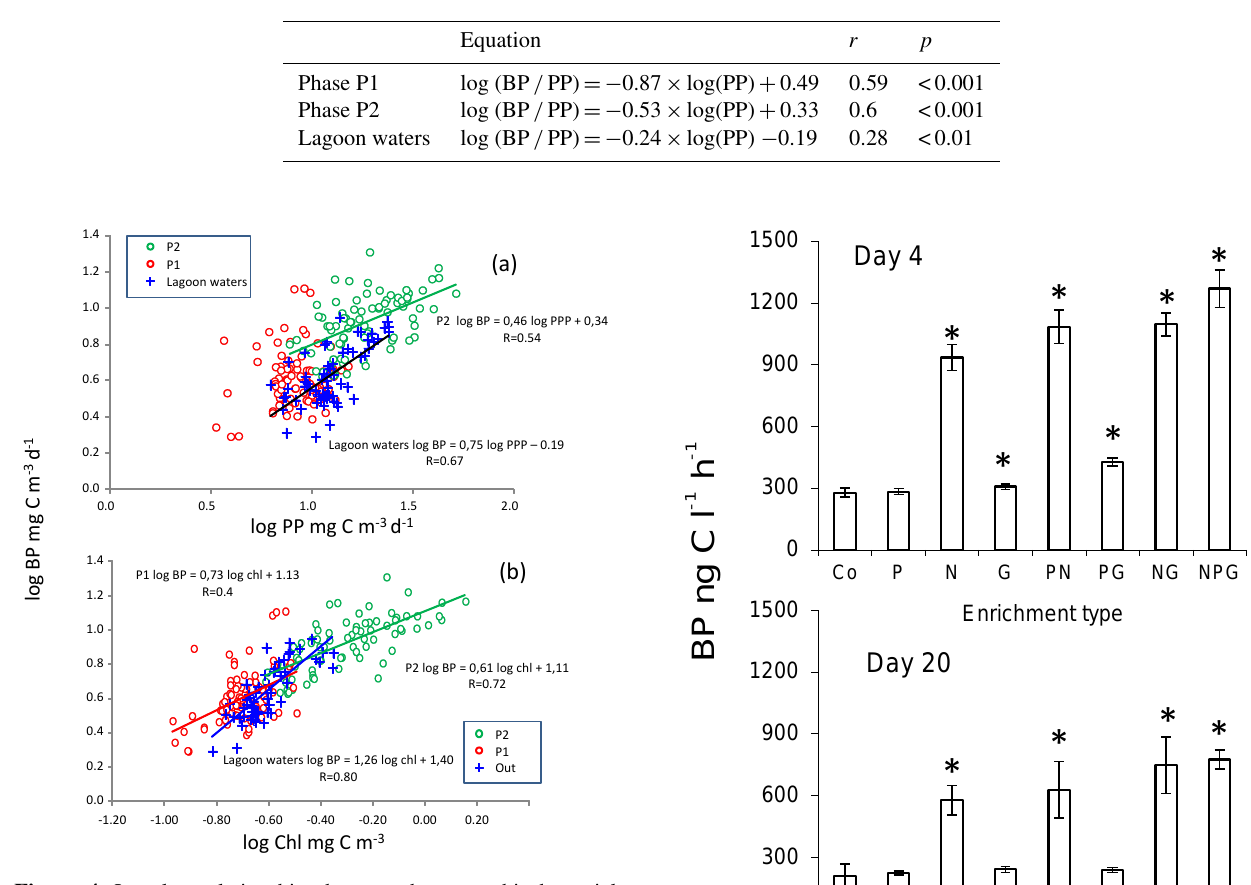
Table 2. Log–log relationships between BP / PP ratio and PP (expressed in mgCm − 3 d − 1 ) . In mesocosms, phase P1 and P2 are separated for the regressions. r : Pearson correlation coefficient, p : probability.